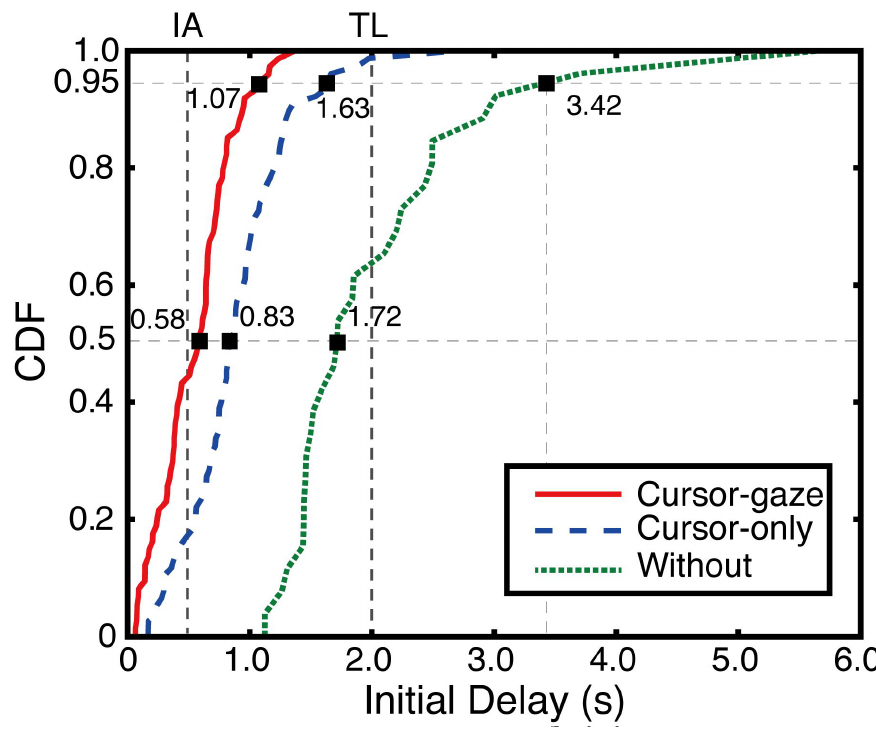
Figure 11. Measured CDF of the initial